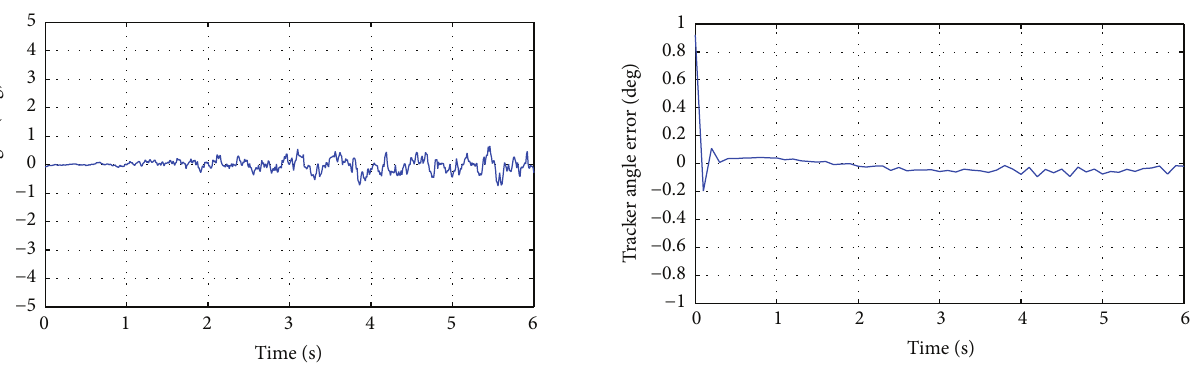
Figure 17: Error for vehicle A tracker.